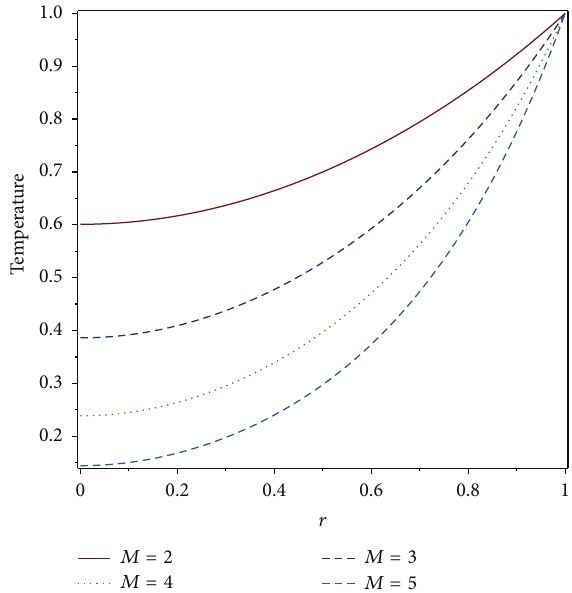
Figure 4: Temperature profile given solutions (14), (16), and (17). Here 𝑀 = 2 and 𝑛 = 0 . Figure 5: Temperature profilegiven solutions(17) for varying values of 𝑀 . Here 𝑛 = 2 is